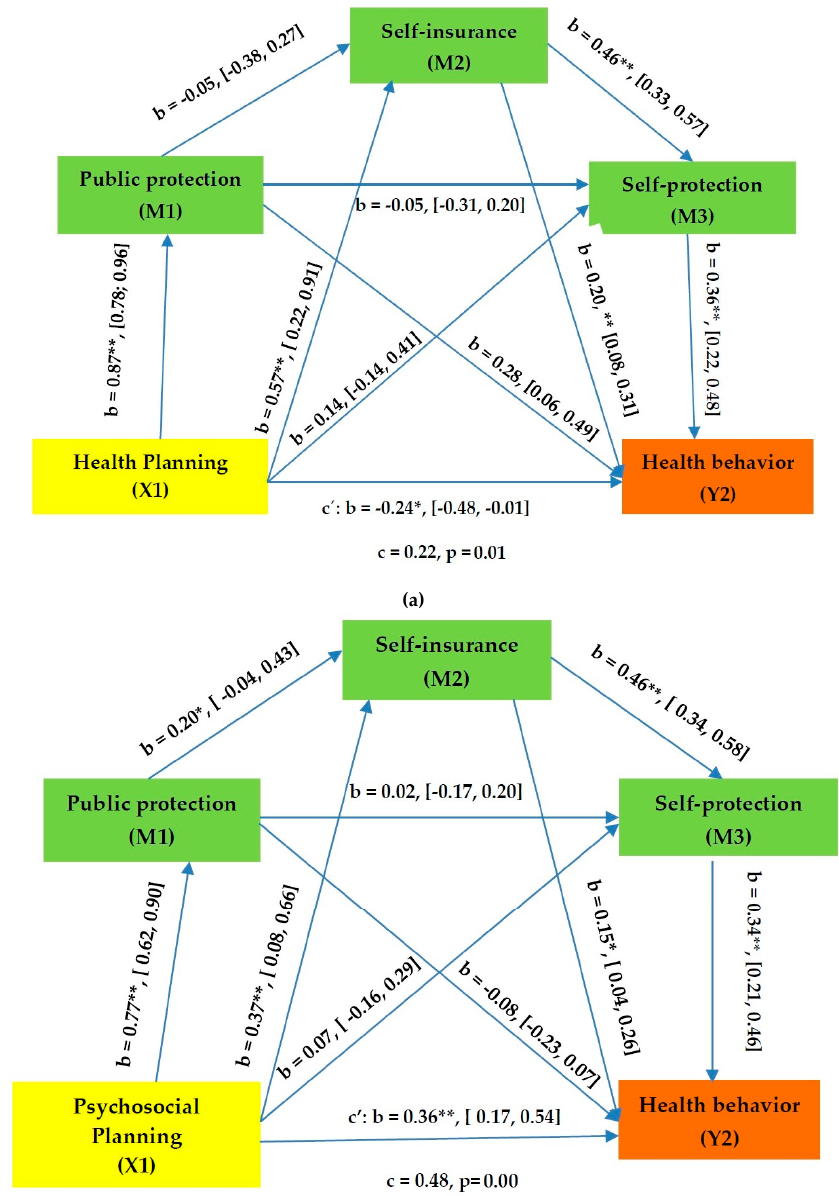
Figure 1. ( a ) Serial mediating effects of Public Protection, Self-insurance and Self-protection in the relationships between Health Planning and Health Behavior ( b ) Serial mediating effects of Public Protection, Self-insurance and Self-protection in the relationships between Psychosocial planning and Health Behavior. Note: B: unstandardized coefficients and 95% Confidence Interval; * p < 0.05; ** p <